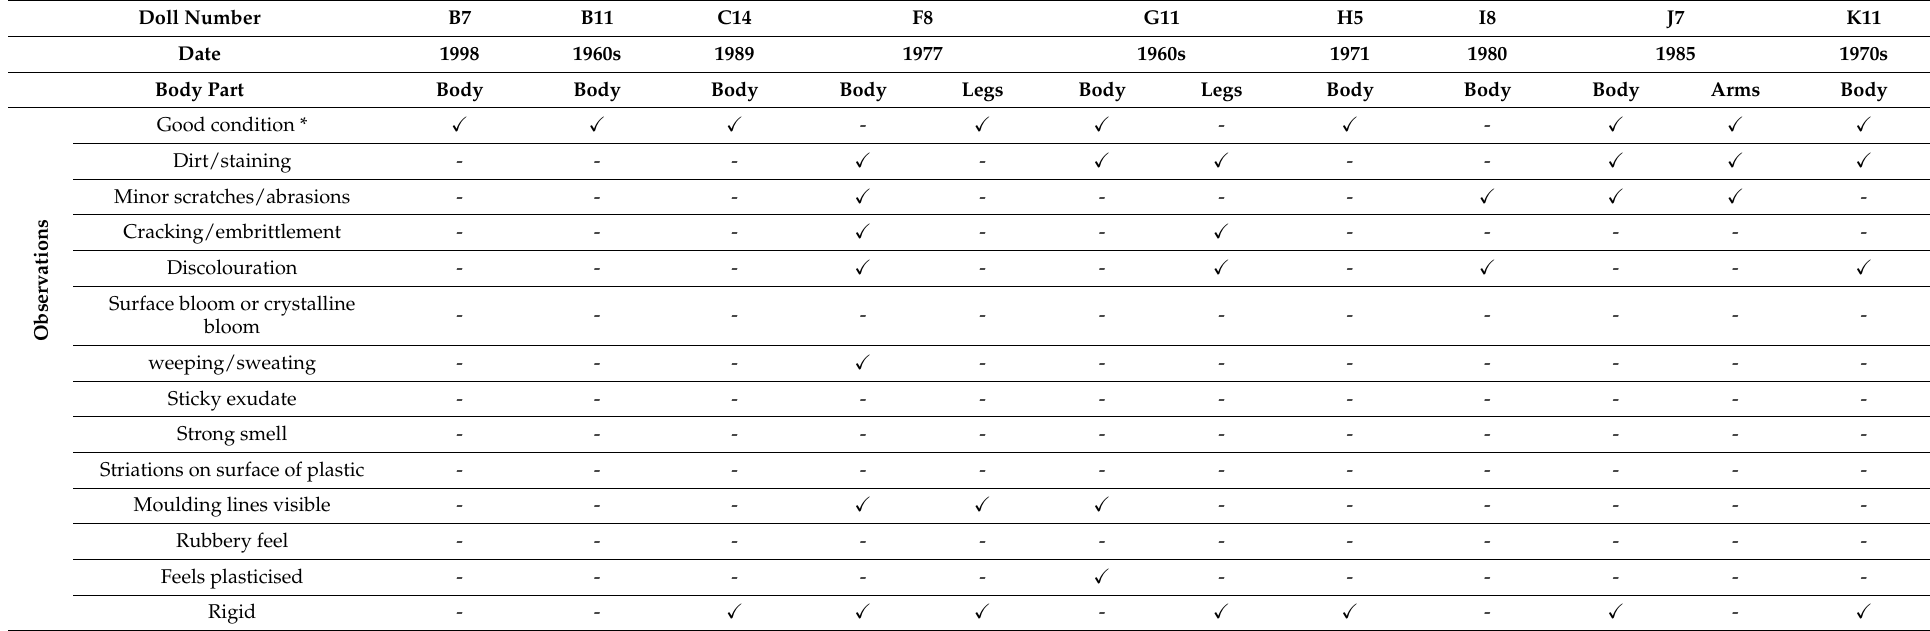
Table 6. Summary of condition of the dolls identified as having PS